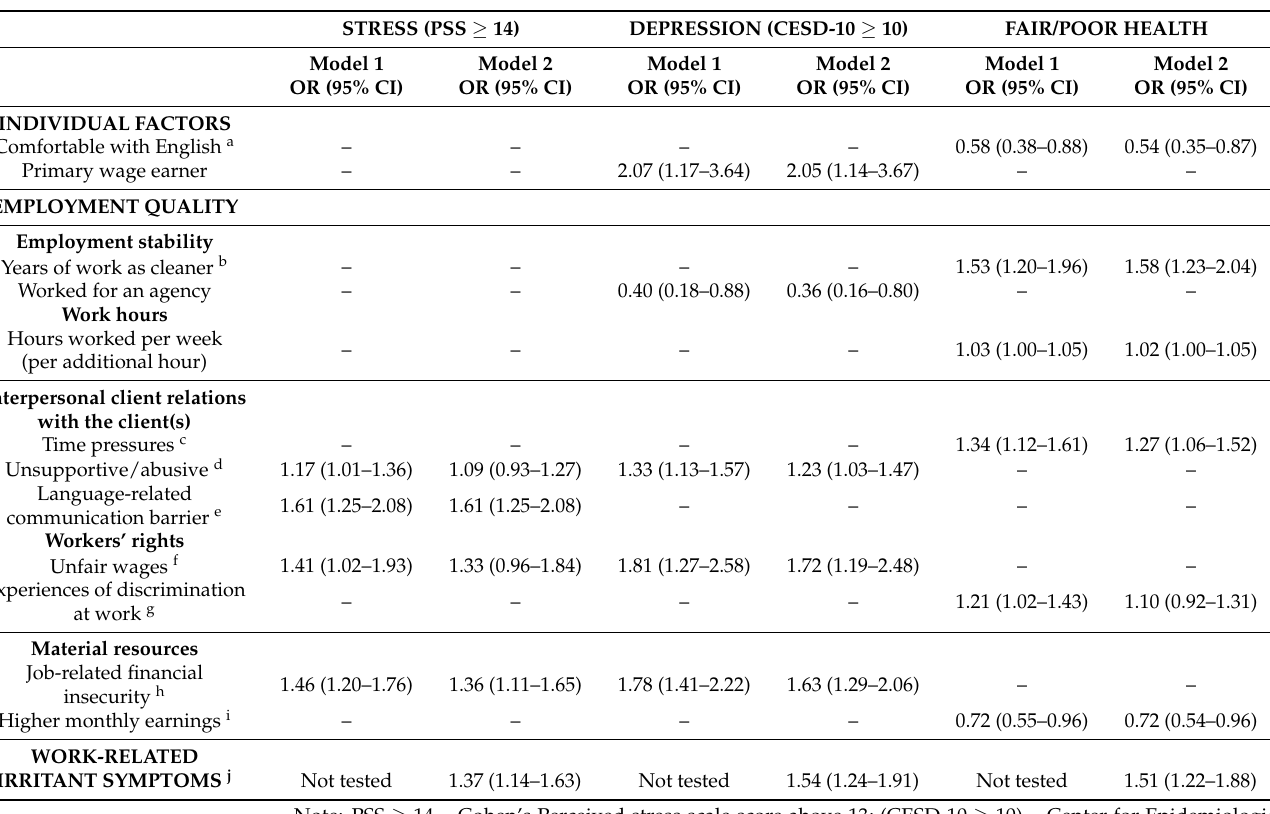
Table 6. Multivariable Logistic Regression Models for Depression, Perceived Stress and Self-Reported Health: Safe and Just Cleaners Study. STRESS (PSS ≥ 14) DEPRESSION (CESD-10 ≥ 10) FAIR/POOR HEALTH Model 1 Model 2 Model 1 Model 2 OR (95% CI) OR (95% CI) OR (95%